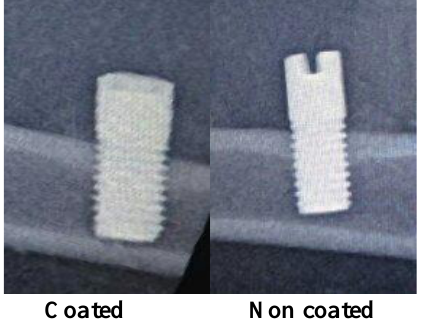
Figure 6: Radiograph of cpTi implants after 4 weeks of implantation Mechanical test